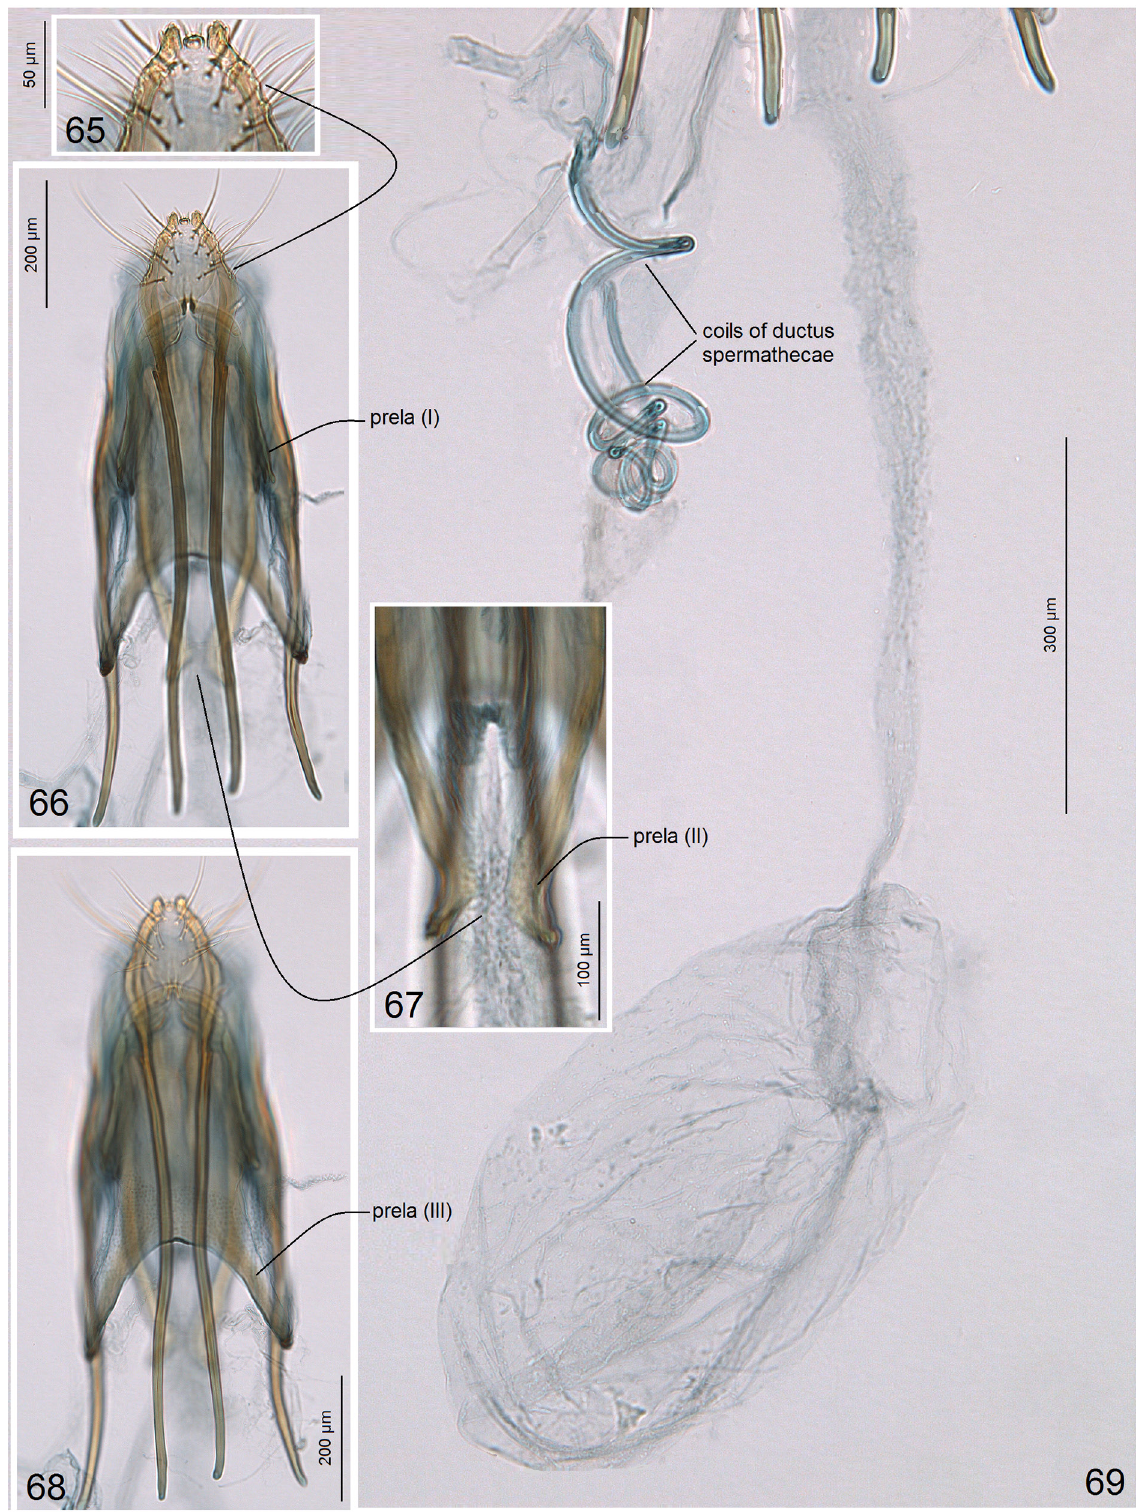
Figs 65–69. Female genitalia of Astrotischeria scutifera Diškus & Stonis, sp. nov., paratype (genitalia slide no. 010316179, NHMUK). 65 . Papillae of ovipositor. 66–68 . Details of prela and apophyses. 69 . Corpus bursae and coils of ductus